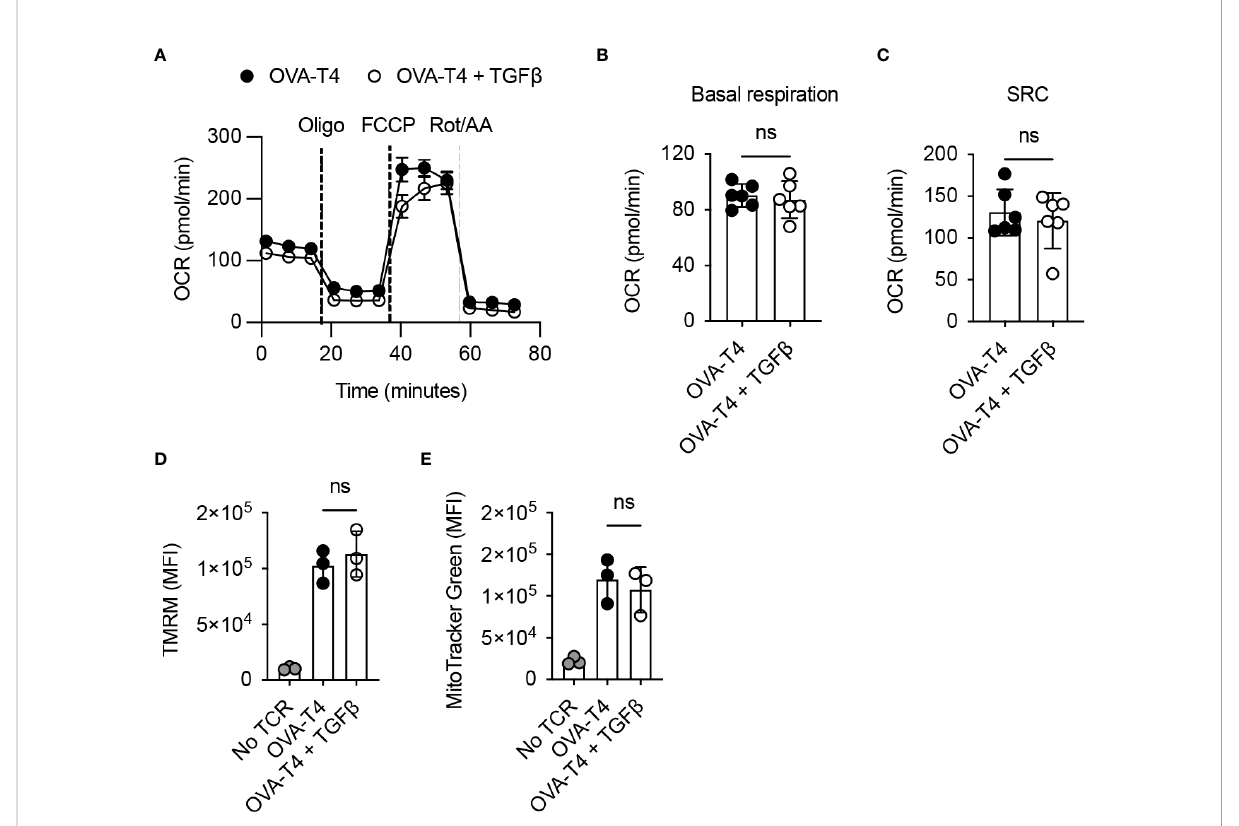
FIGURE 5 TGF b inhibits CD8 + T cell activation independently of effects on mitochondrial metabolism OT-I TCR transgenic T cells were stimulated with SIITFEKL (OVA-T4) peptide in the presence or absence of TGF b for 48 hours. (A) Seahorse metabolic analysis determined oxygen consumption rates (OCR) of OT-I T cells. Dotted vertical lines represent injection times for oligomycin (Oligo), carbonyl cyanide-p- tri fl uoromethoxyphenylhydrazone (FCCP) and rotenone/antimycin A (Rot/AA) in the MitoStress Test ™ . Basal respiration (B) and spare respiratory capacity (SRC) (C) were determined as baseline OCR values and OCR values following FCCP injection, respectively. Mitochondrial membrane potential (D) and mitochondrial mass (E) were assessed by fl ow cytometry analysis of tetramethylrhodamine methyl ester (TMRM) and mitotracker green fl uorescence, respectively. For fl ow cytometry analyses, data shown represent mean fl uorescence intensity (MFI) values. Individual data points represent technical replicates (n=3-6) from 1 of 3 repeated experiments. NS – not signi fi cant as assessed by Student ’ s